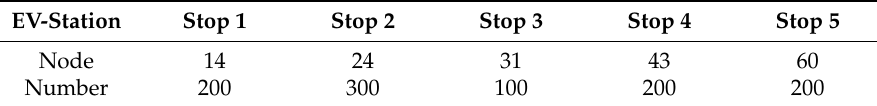
Figure 13. An IEEE 69 ‐ bus distribution network. Table 5. The number of EVs in each EV ‐ station.